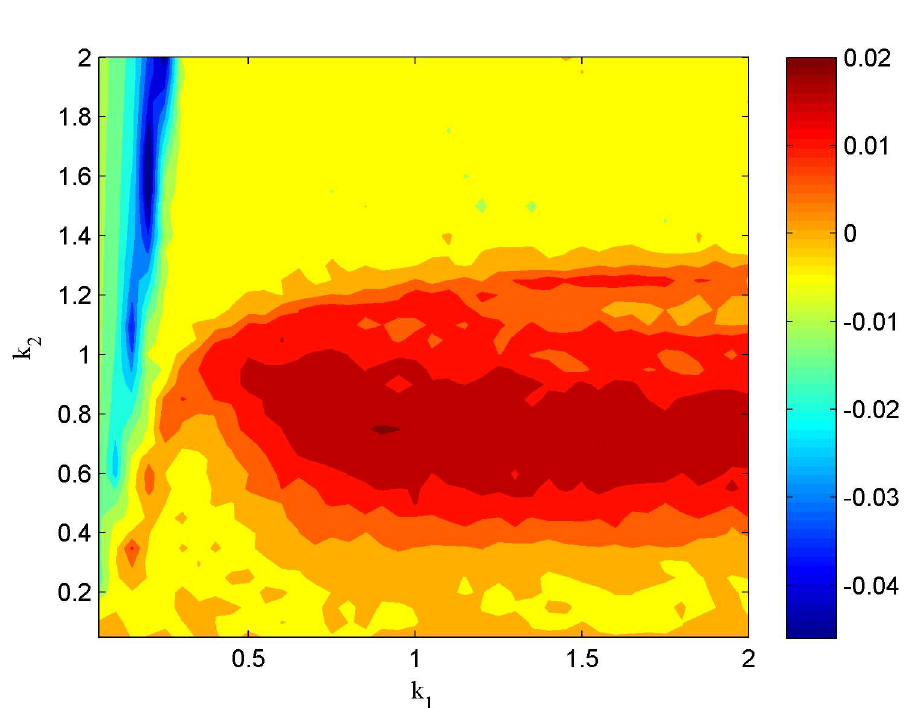
Fig 9. The largest Lyapunov exponent in the two-parameter region ( k 1 , k 2 ).